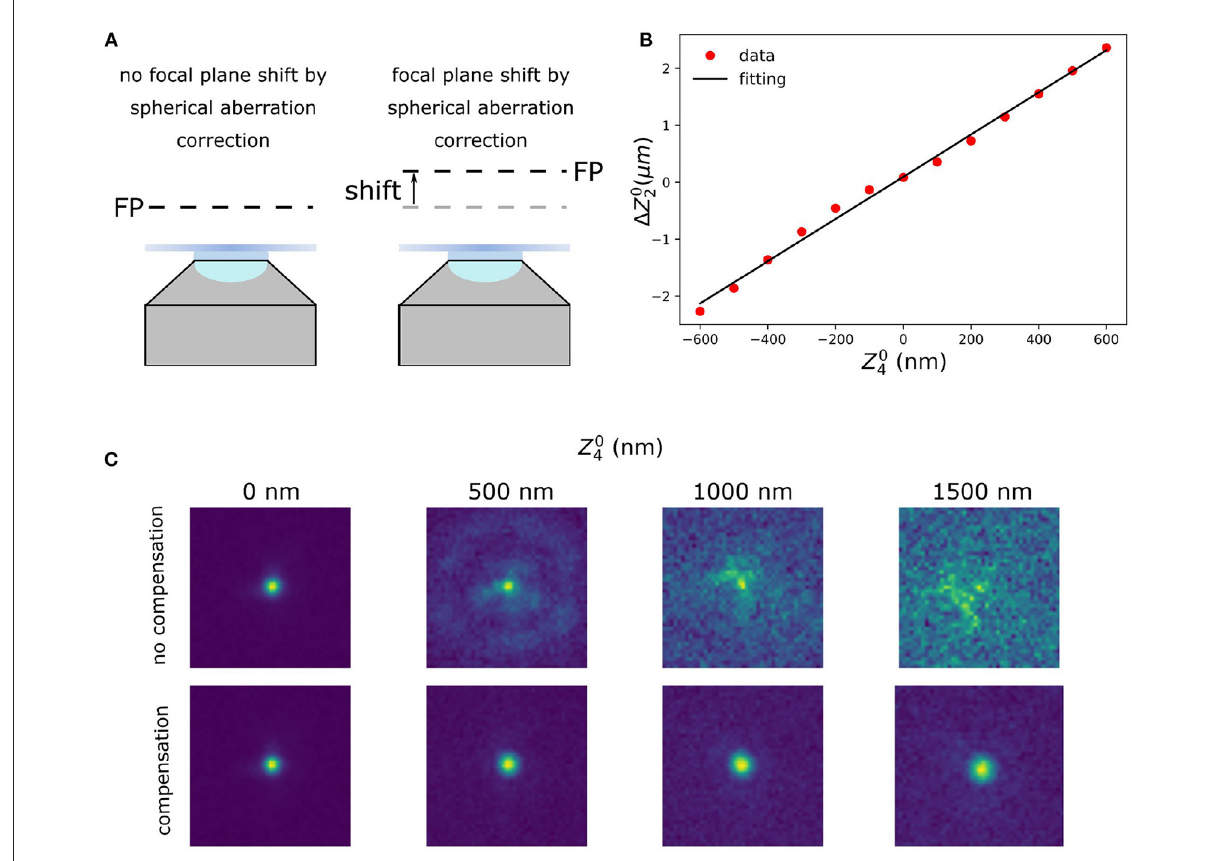
FIGURE2 Defocus calibration for spherical aberration compensation. (A) Focal plane shift induced by coupling between defocus and spherical aberration. When correcting for the spherical aberration, the coupling between the spherical and the defocus aberration shifts the focal plane (FP). (B) Calibration of the compensation for the defocus introduced by spherical aberration. (C) Raw data with different amount of spherical aberration (Z 0 4 : 0, 500, 1,000, and 1,500 nm) without (upper row) and with (lower row) defocus compensation. The calibration was done with spherical aberration in the range of –600 ∼ 600